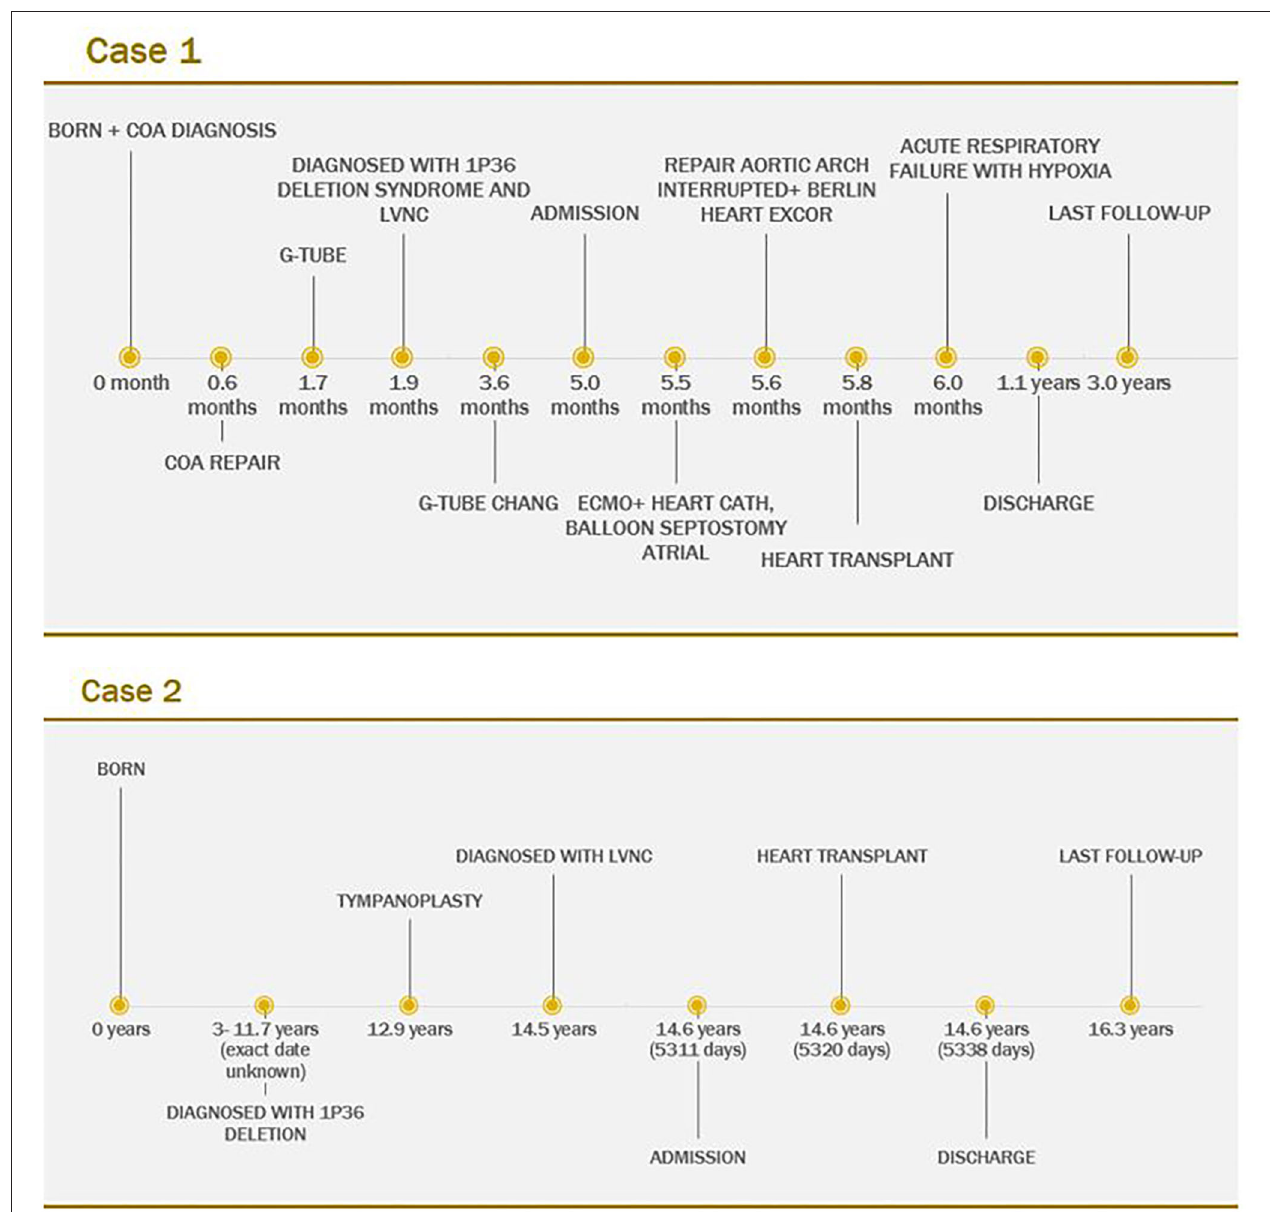
FIGURE 4 | Timeline of Case 1 and Case